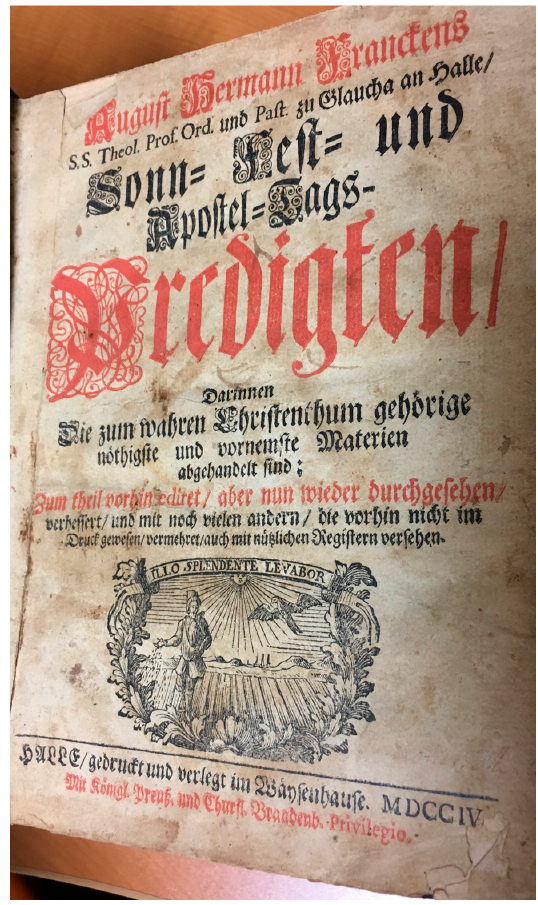
Figure 2. The seal as it appears on a full title page (Francke 1704). August Hermann Francke. Sonn-Fest-und Apostel-Tags-Predigten. Halle: Wäysenhause, 1704. Special Collections, A. R. Wentz Library, United Lutheran Seminary—Gettysburg. Photographed by author.